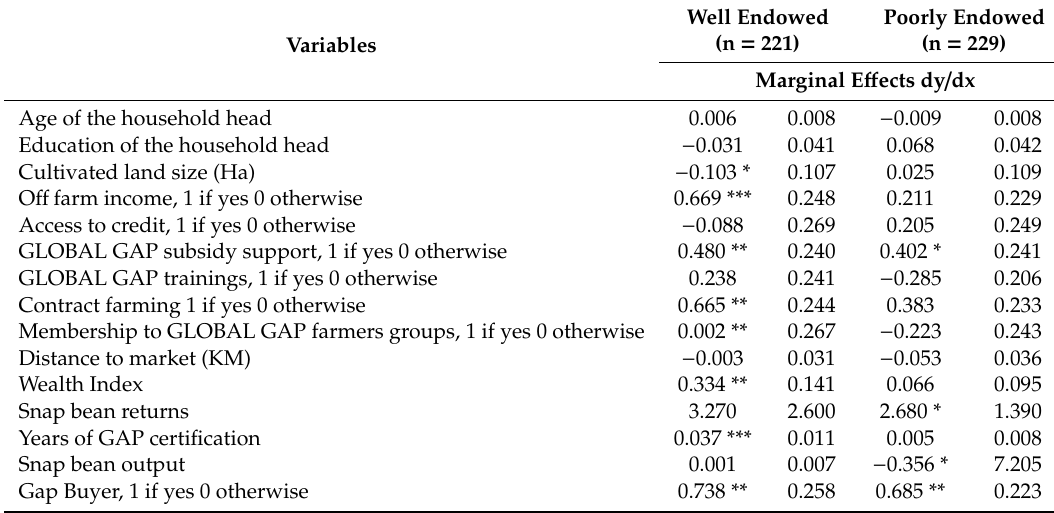
Table 6. Marginal E ff